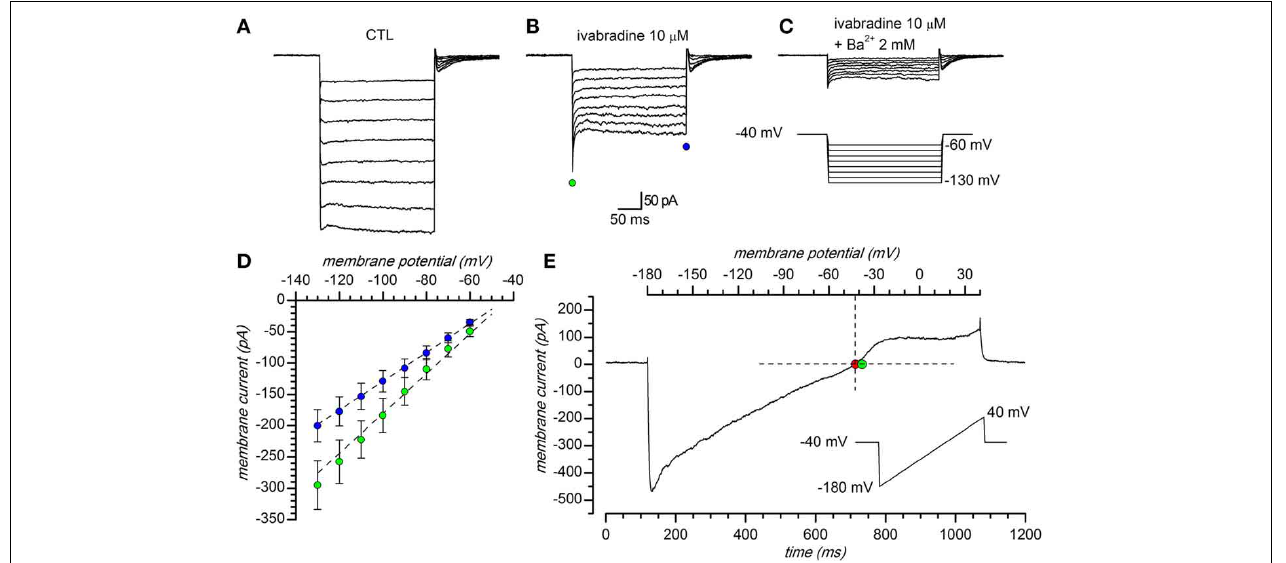
FIGURE 1 | General properties. (A–C) Representative currents obtained in response to hyperpolarizing pulses in 32.5mM external K + solution: (A) EC1 saline with 1mM kynurenic acid, 10 μ M bicuculline (BL1 mix), 0.6 μ M TTX, 100 μ M Cd 2 + ; (B) same solution as in A plus 10 μ M ivabradine; (C) same solution as in B plus 2mM Ba 2 + . Voltage steps from a holding potential of − 40mV with hyperpolarizing steps ranging from − 60 to − 130mV in 10mV increments. (D) : I–V relationship of peak (green dots) and steady-state (blue dots) current; mean current amplitude of 81 cell recordings. Vertical error bars